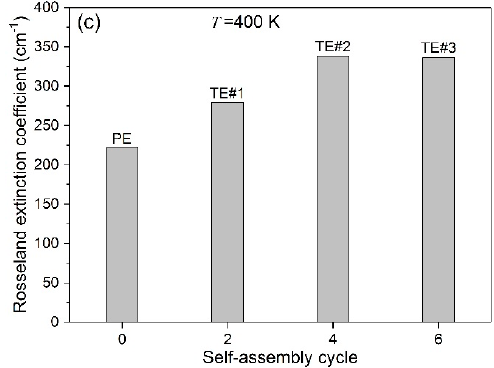
Figure 10. Rosseland mean extinction coefficient for various self-assembly cycles at ( a ) 300 K; ( b ) 350 K, and ( c ) 400 K.